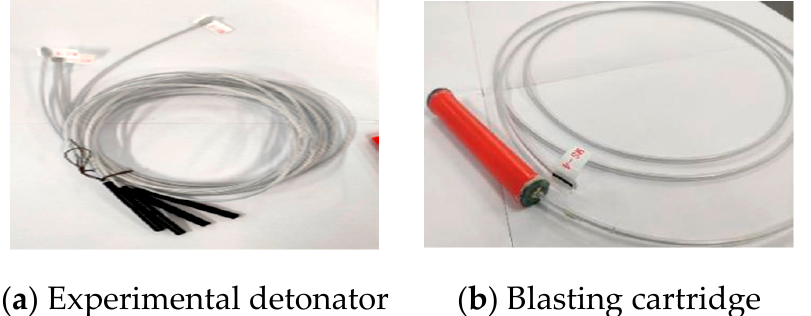
Figure 5. Experimental cartridge production system: ( a ) experimental detonator and ( b ) blasting cartridge.